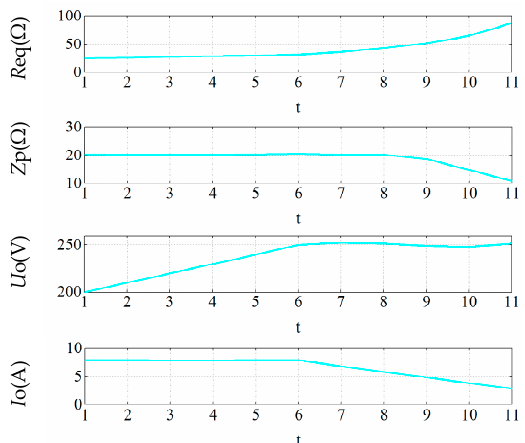
Figure 19. The experimental waveform diagram under the primary side impedance control scheme.